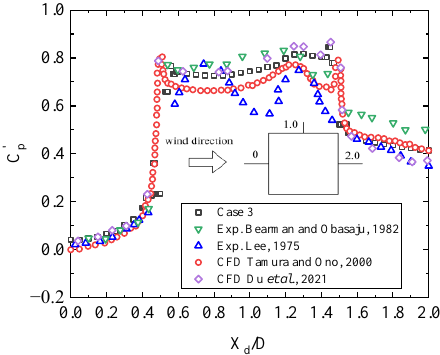
Figure 6. Comparison of fluctuating wind pressure coefficients.